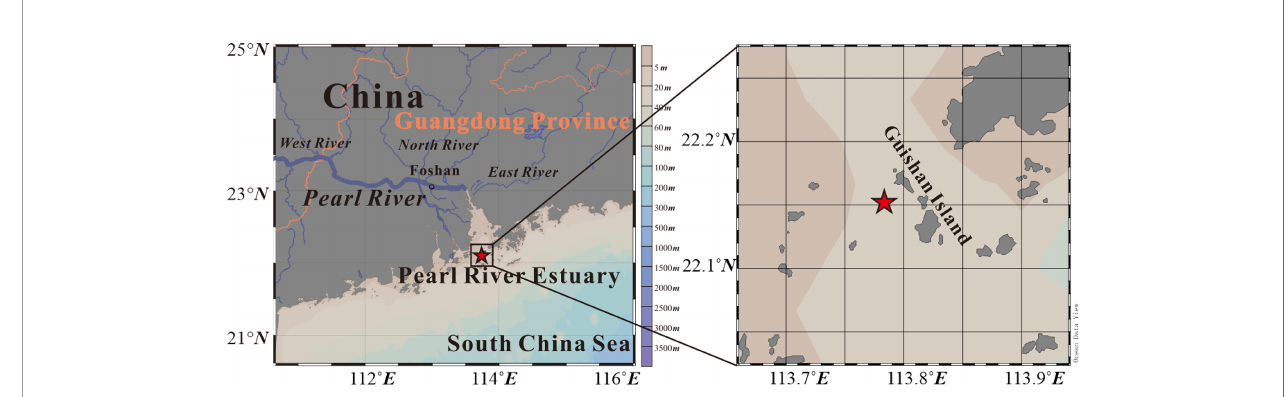
FIGURE 1 | Sampling site of the sediment core from Guishan Island, Pearl River Estuary. The three main tributaries of North River, West River, and East River are